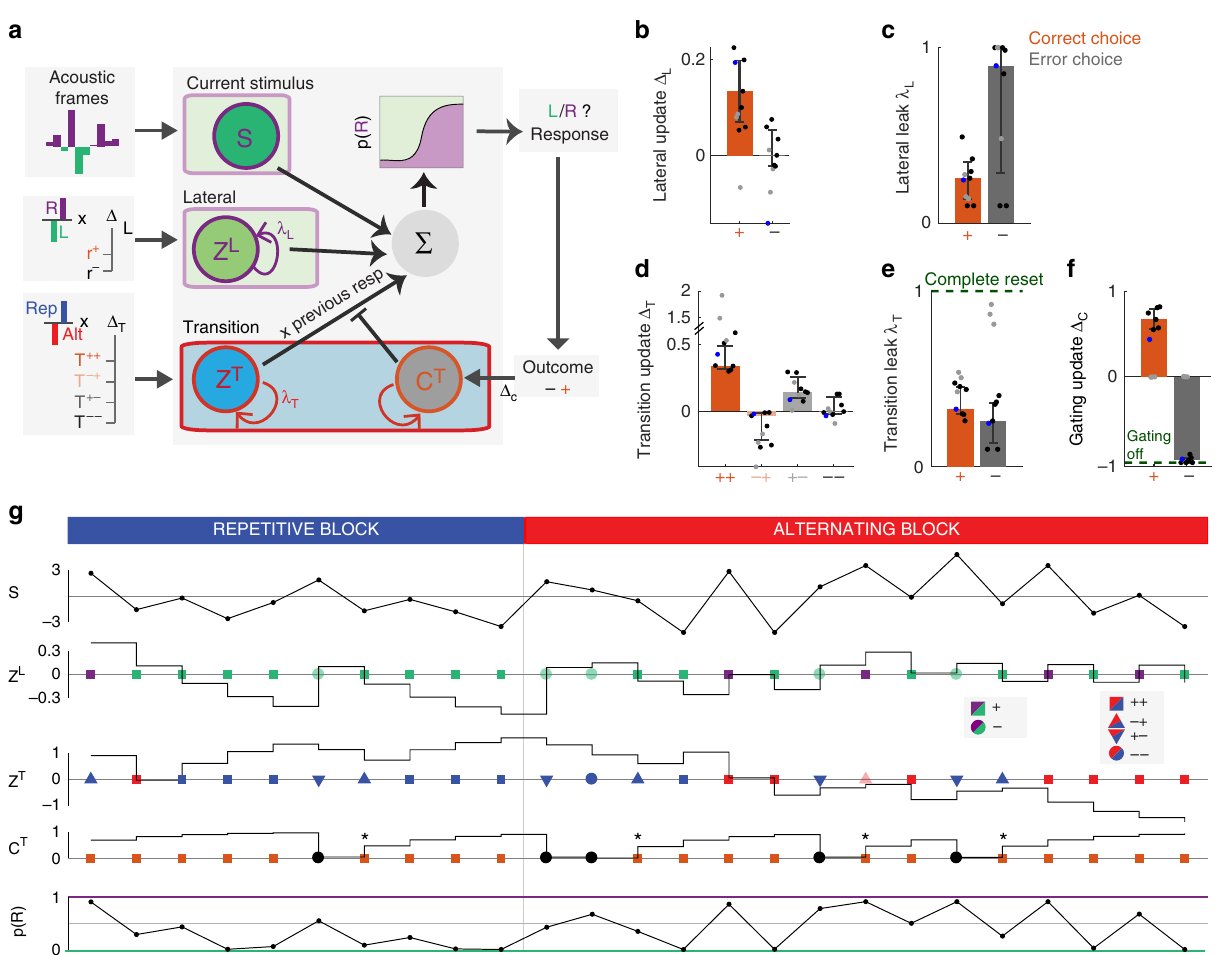
Fig. 6 Dynamic generative model of history-dependent perceptual decisions. a Architecture of the model. The sensory module accumulates the instantaneous stimulus evidence of the current trial. The lateral module maintains the lateral evidence z L , which is updated depending on the last response and its outcome (updates Δ L ). The transition module maintains the transition evidence z T , which is updated depending on the last transition (i.e., ++ , − + , + − , −− ; updates Δ T ). The modulatory signal c T is updated based on the last outcome (updates Δ C ). The transition bias is obtained from the product γ T = z T × c T × r t − 1 . The sum of sensory evidence and the lateral and transition biases determined the probability to choose either response at the current trial. Parameters were fi tted to the choices of each rat separately. b – e Best- fi tting values of the model parameters. Bars show median across seven rats (black and blue points). Three rats were excluded from the statistics because the fi tted model yielded a solution without gating dynamics (gray points). b Lateral evidence outcome-dependent update Δ L . c Outcome-dependent leak of the lateral bias λ L . d Transition evidence update Δ T , depending on the outcome of the last two trials ( ++ , − + , + − , −− ). e Outcome-dependent leak of the transition bias λ T . f Outcome-dependent update of the transition gating signal Δ C . A value of − 1 corresponds to an extinction of the gating signal on the subsequent trial (i.e., a full blockade of the corresponding bias), while + 1 corresponds to full recovery of the bias (i.e., gating equal to its maximum value of 1). g Example traces of the dynamics of the latent variables across 25 trials switching from a repetition to an alternation block ( fi tted parameters correspond to rat 12 shown as blue points in b – e ). Traces depict the variables stimulus evidence S , z L , z T , c T , and overall probability to choose a rightward response. Symbols on the corresponding trial axis represent inputs to the variables z L , z T , and c T : left (green) vs. right (purple) responses; repeating (blue) vs. alternating (red) transitions; and rewarded (orange) vs. error (black) outcomes. Symbols shape represent different outcome combinations (see inset). Notice the reset of c T after errors and the maintenance of z T afterwards